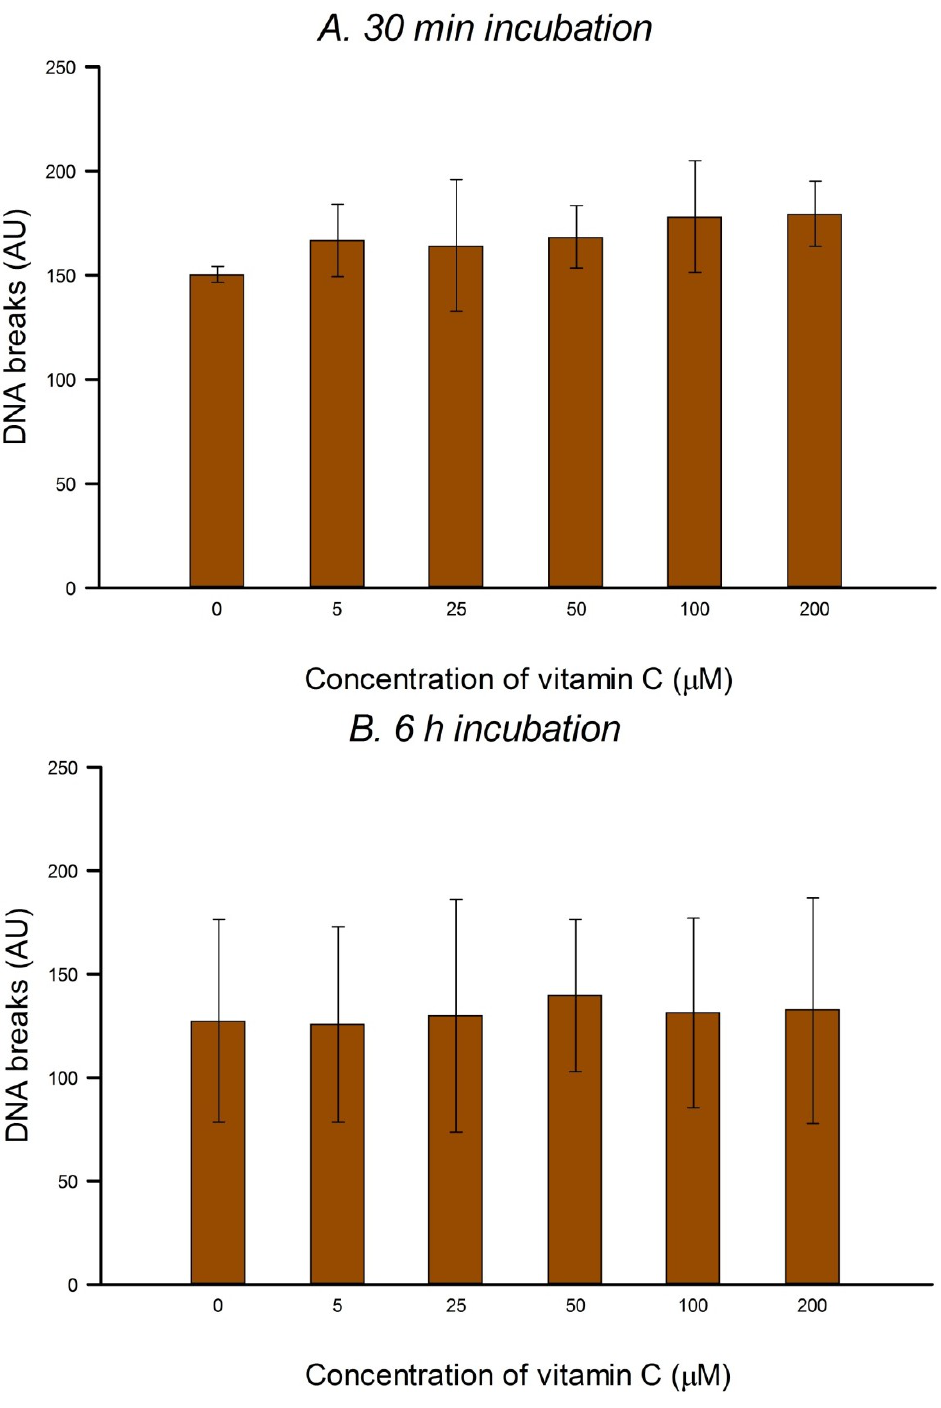
Figure 2. Effect of pre-incubation of HeLa cells with different concentrations of vitamin C for 30 min ( A ) or 6 h ( B ) on damage induced by H calculated by subtracting comet score without H score with H O . Bars: SD calculated from the results of 3 independent experiments. 2 2 No significant effects were